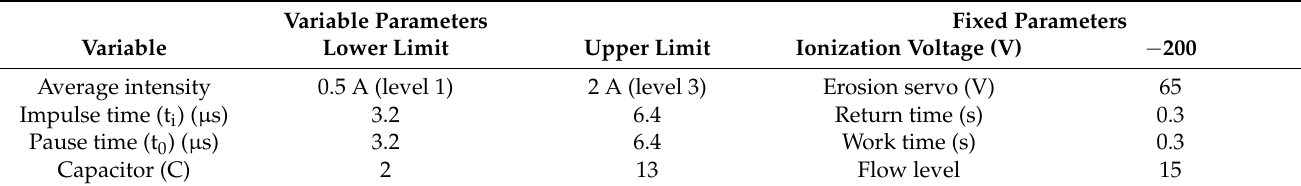
Table 3. Variable and fixed parameters of the EDM Cu–Al process.